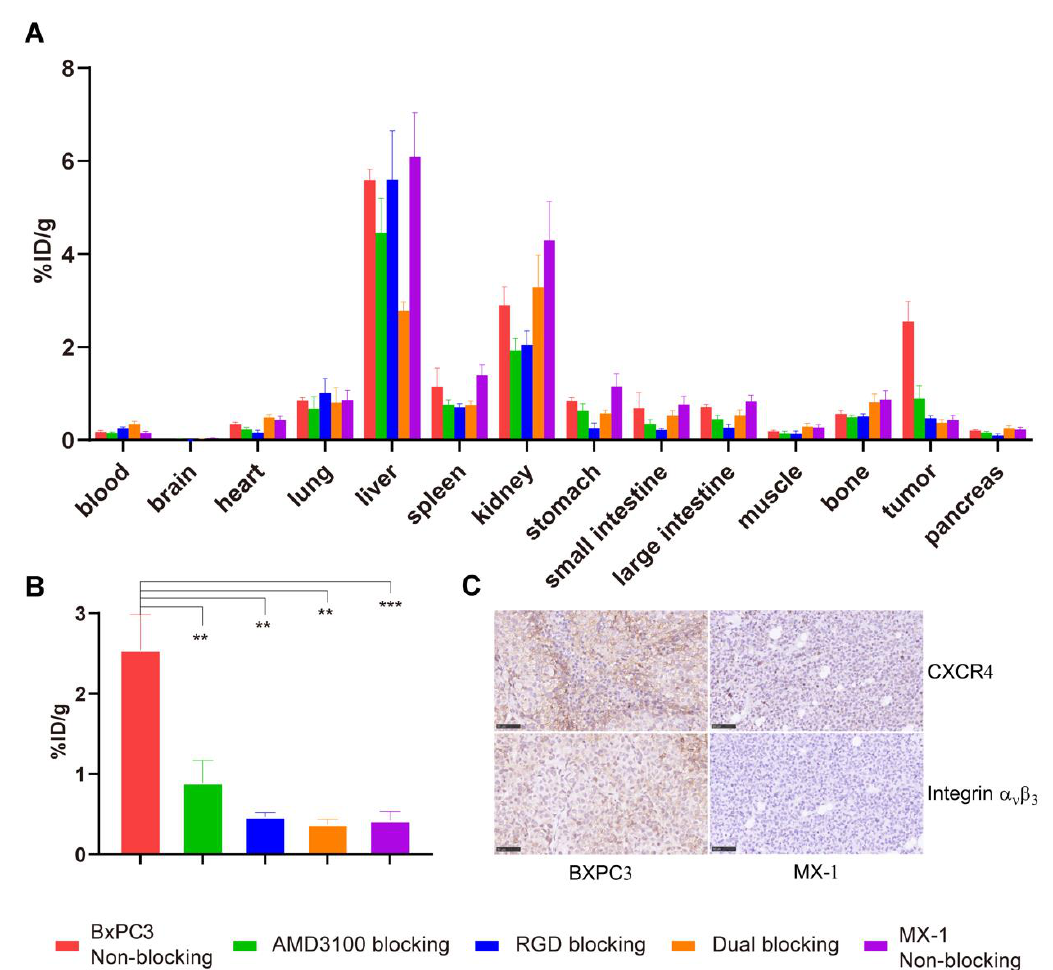
Figure 5. Ex vivo biodistribution studies and immunohistochemistry assays show the specificity of 68 Ga-yG5-RGD for CXCR4 and integrin α v β 3 expression on tumors. ( A , B ) Biodistribution results and tumor uptake comparisons of 68 Ga-yG5-RGD in BxPC3 tumors with or without co-injection of excess amount of unlabeled AMD3100 (10 mg/kg), RGD (10 mg/kg), and AMD3100 (10 mg/kg) + RGD (10 mg/kg) and in MX-1 tumors at 2 h p.i. (each 5.55 – 7.4 MBq). ( C ) Immunohistochemistry assay of CXCR4 and integrin α v β 3 in BxPC3 and MX-1 tumors (×400). Data are expressed as mean ± SD, n = 4; ** p < 0.01, *** p < 0.001, Scale bar = 50 μm.